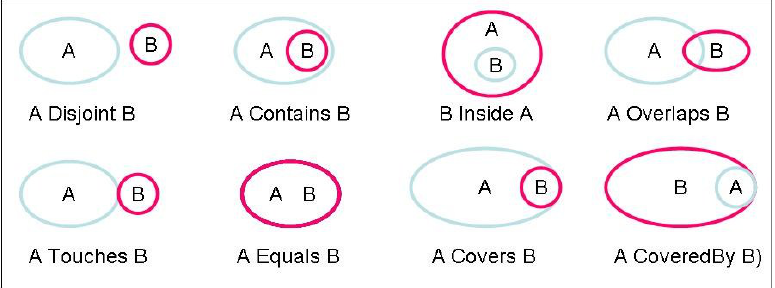
Figure 1. Example of the beginning of a geographic ontology with only “is-a” relationships.